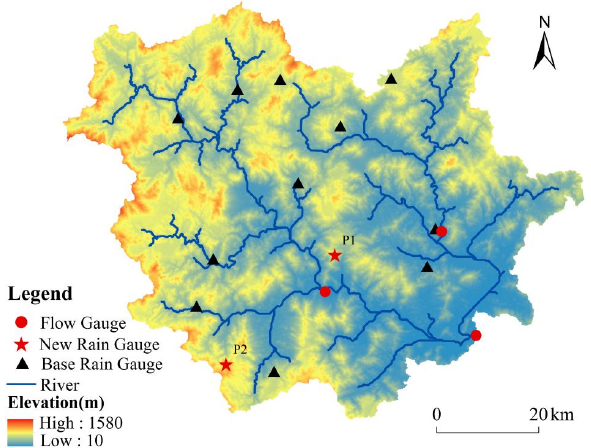
Figure 4. Optimal rain gauge network based on the OK–SCA.